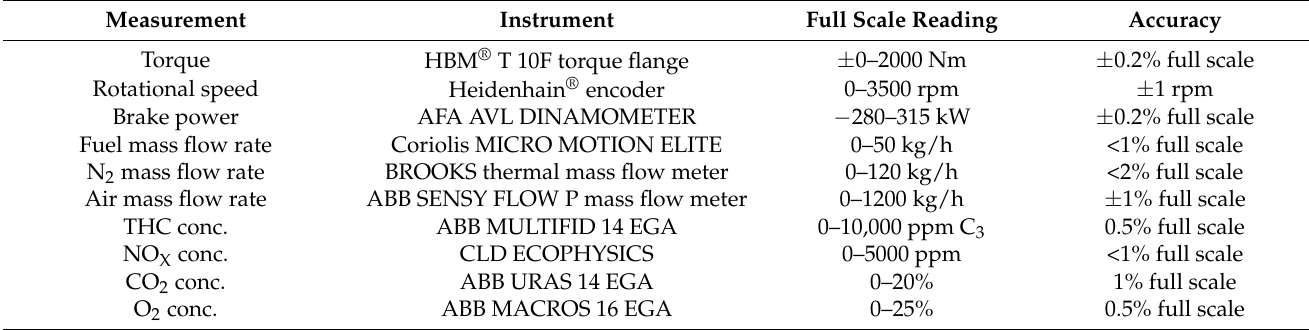
Table 7. Main characteristics of the test